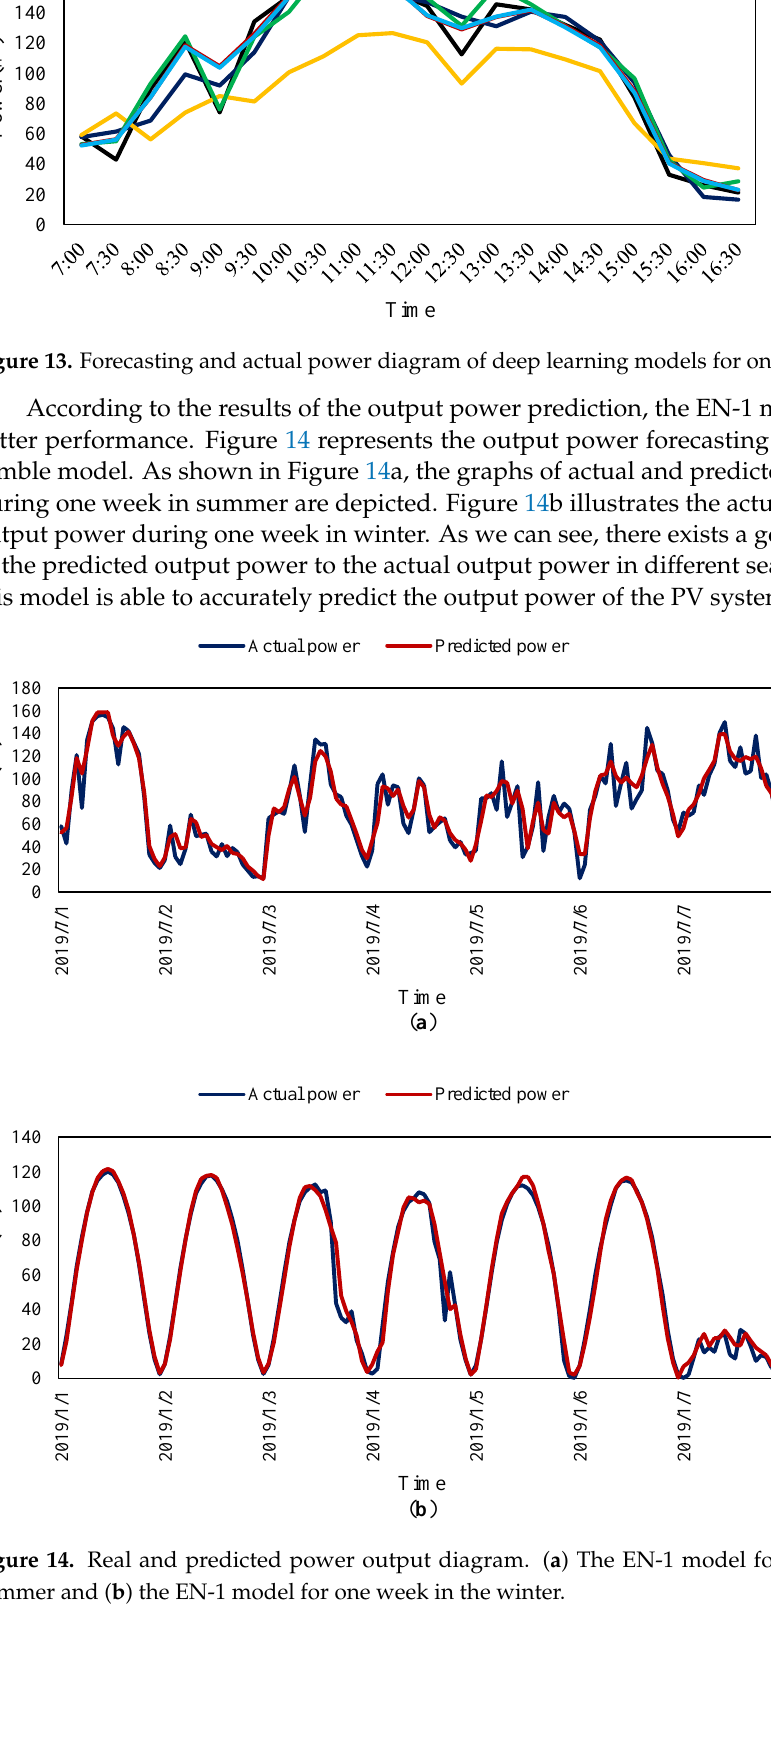
Figure 14. Real and predicted power output diagram. ( a ) The EN-1 model for one week in the summer and ( b ) the EN-1 model for one week in the winter.